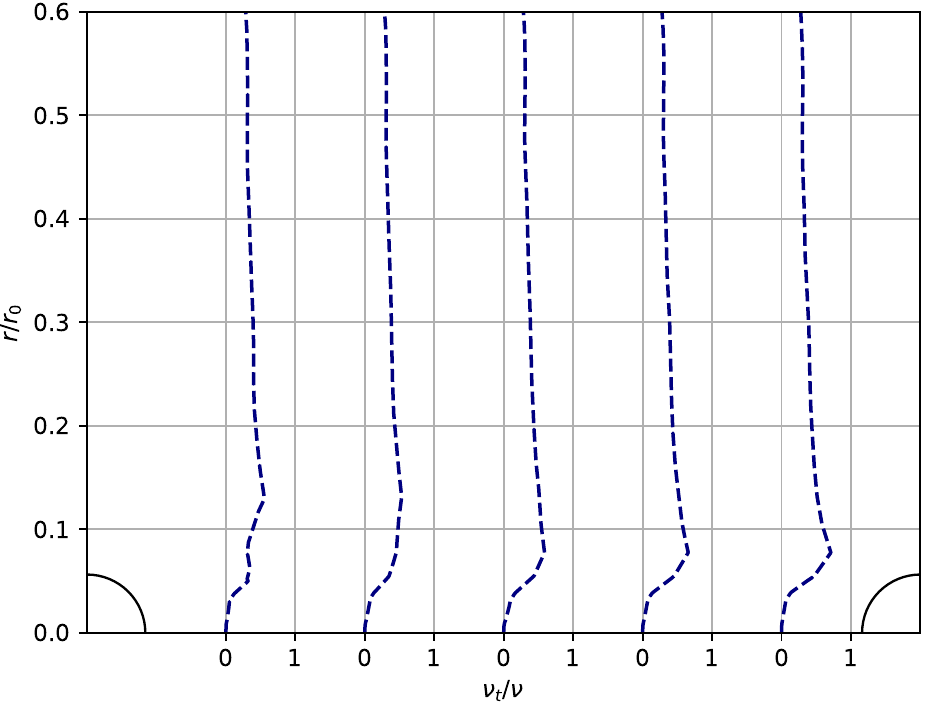
Figure 9. Representation of the turbulent viscosity in relation to the molecular